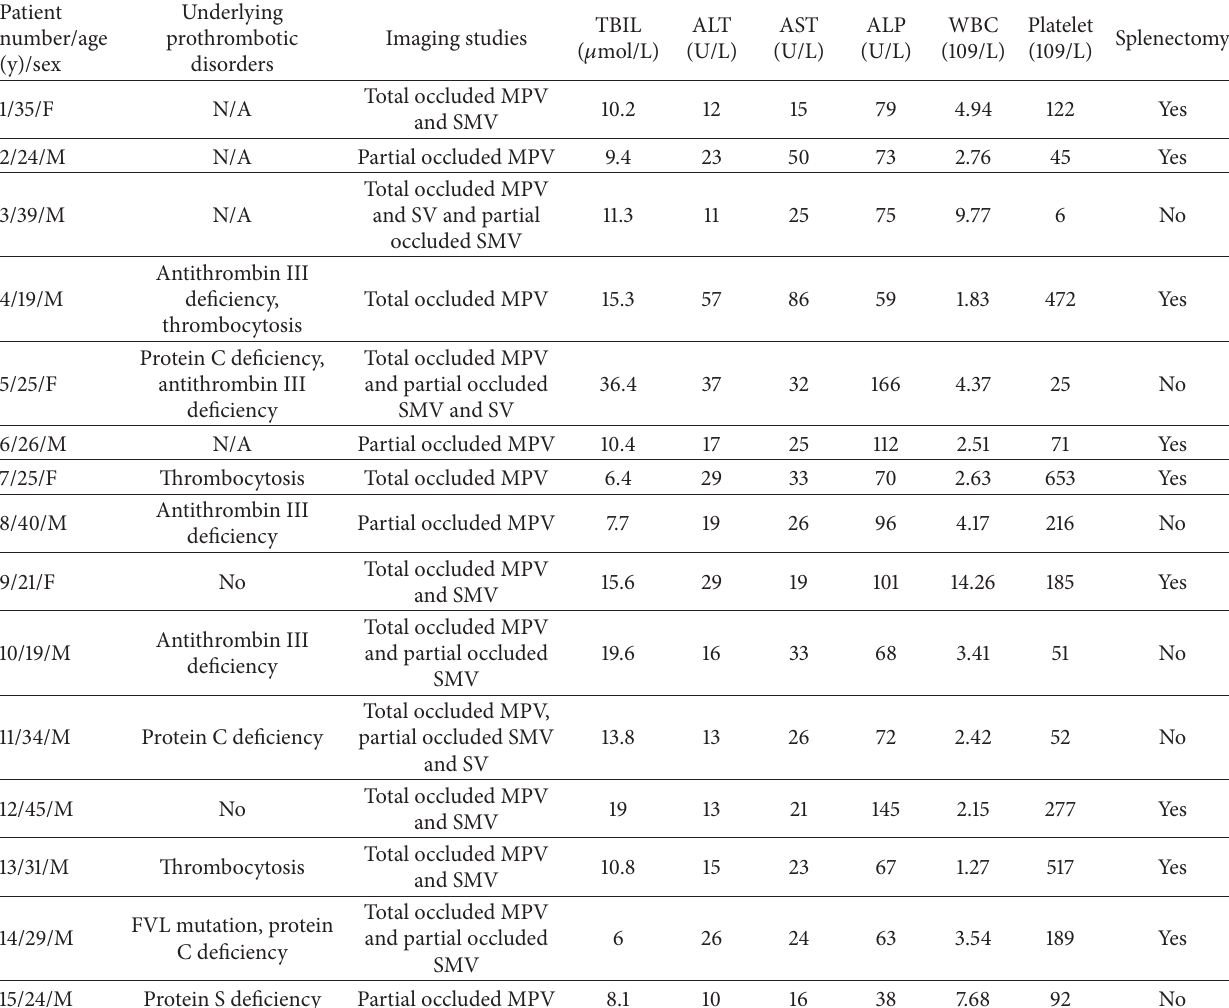
Table 1: Patient characteristics, previous history of splenectomy, imaging studies, and laboratory